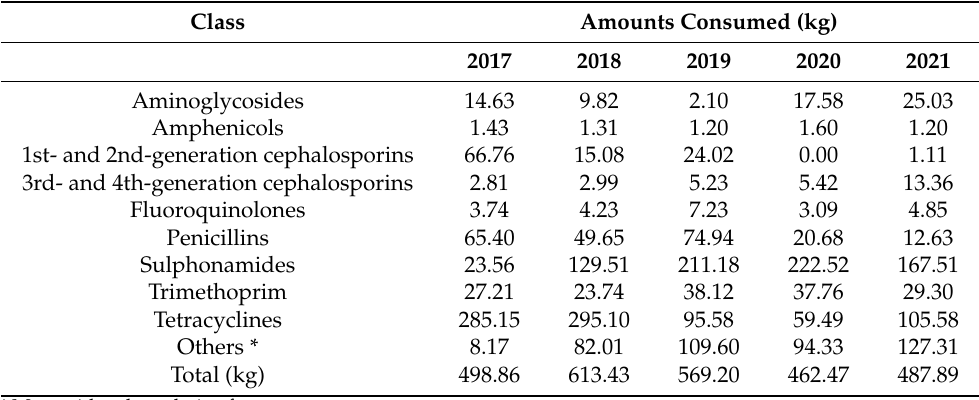
Table 4. Consumption of different classes of antimicrobials by livestock in